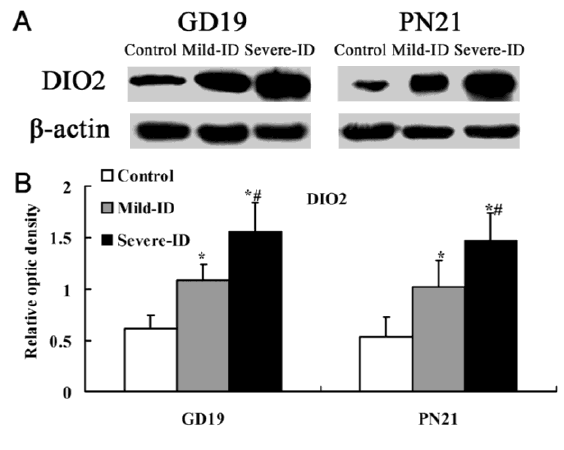
Figure 7. Up-regulated protein levels of DIO2 in the thyroid. The upper bands ( A ) depict representative findings for rats subjected to mild ID and severe ID. The lower bar graphs show the results of the semi-quantitative measurement of DIO2 ( B ) following mild ID and severe ID treatment. The height of each bar represents the mean ±SD for the groups. At each time point, * compared to the control, p < 0.05; # compared to the mild ID, p < 0.05 (n =